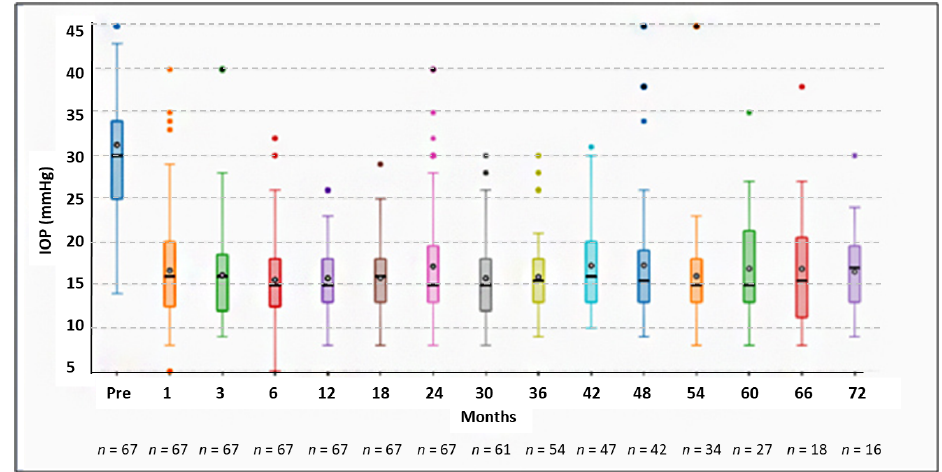
Figure 1. Box plot representation of IOP values over time in 7 years of follow-up in the cohort of 67 PEXG eyes that underwent canaloplasty. The scatter plot in Figure 2 shows the pre-operative IOP and post-operative IOP values after 2 years.